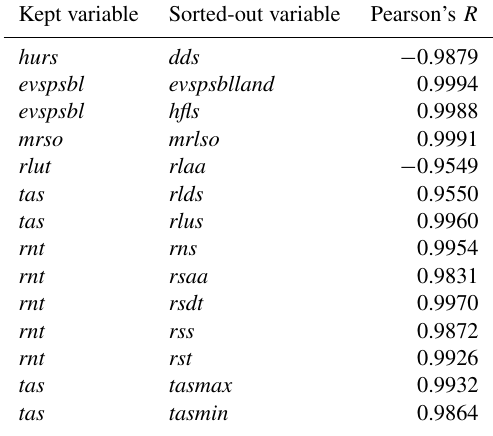
Table 2. List of sorted-out variables. Kept